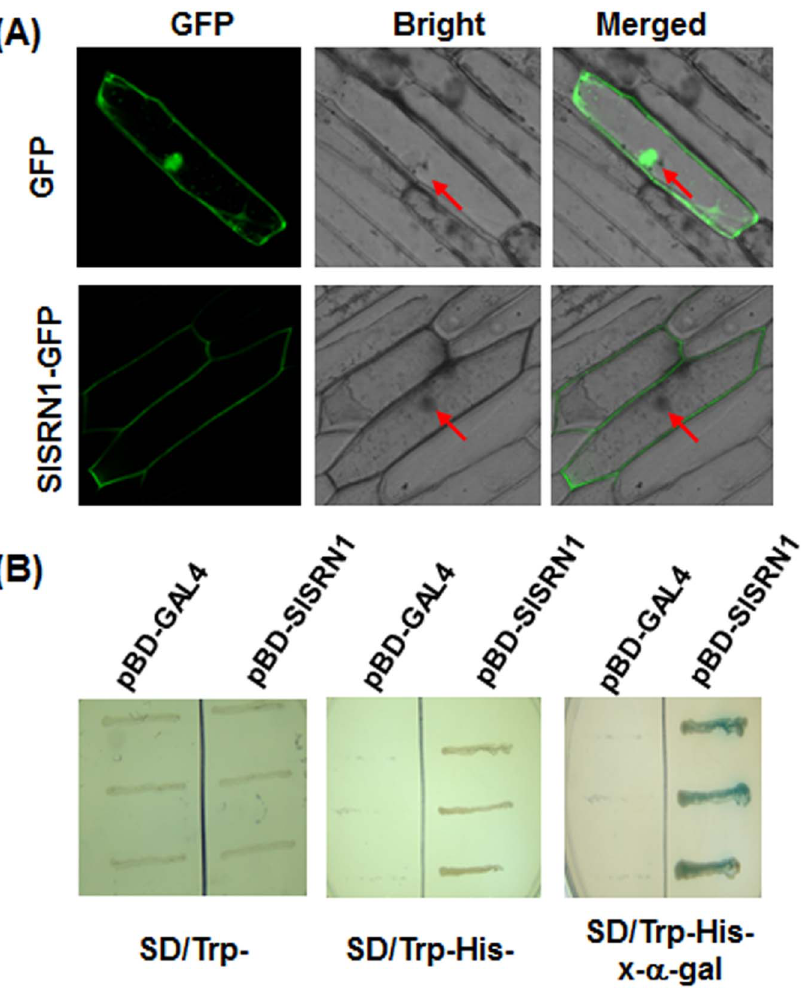
Figure 2. Subcellular localization and transactivation activity of SlSRN1. A. Subcellular localization of SlSRN1 when transiently expressed in onion epidermal cells. Onion epidermal cells were transiently transformed with either control GFP vector (upper) or SlSRN1-GFP construct (lower) by particle bombardment. The subcellular localization of the SlSRN1-GFP fusion protein and GFP alone were viewed at 24 hr after bombardment under a confocal laser microscopy in dark field for green fluorescence ( left ), in white field for the morphology of the cell ( middle ), and in combination ( right ), respectively. Red arrows indicate the nucleuses of the onion epidermal cells. B. Transactivation activity of SlSRN1 in yeast. Yeasts carrying pBD-SlSRN1 or pBD empty vector (as a negative control) were streaked on the SD/Trp 2 plates ( left ) or SD/Trp 2 His 2 plates ( middle ) for 3 days at 28 u C. The x- a -gal was added to the SD/Trp 2 His 2 plates and kept at 28 u C for 6 hr ( right ).